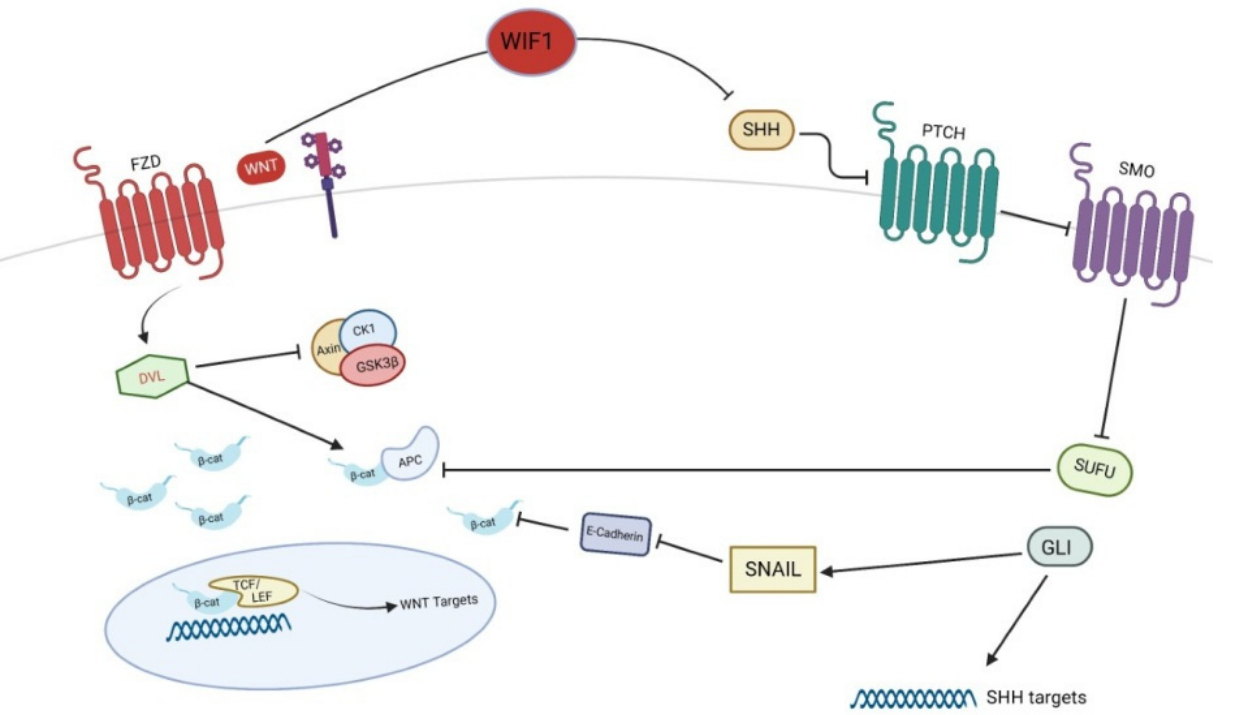
Figure 2. Crosstalk between SHH and Wnt pathways in pathogenesis of basal cell carcinoma. WIF-1, Wnt inhibitory factor-1; SHH, Sonic Hedgehog; PTCH, patched; SMO, smoothened; SUFU, suppressor of fused; GLI, Glioma associated oncogene homolog